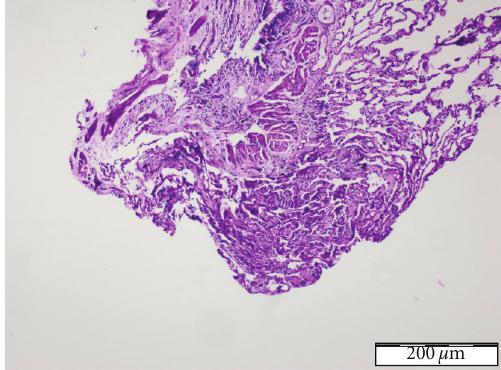
Figure 3: Hepatic parenchymal inflammatory cell infiltrates and sinusoidal dilatation in liver biopsy